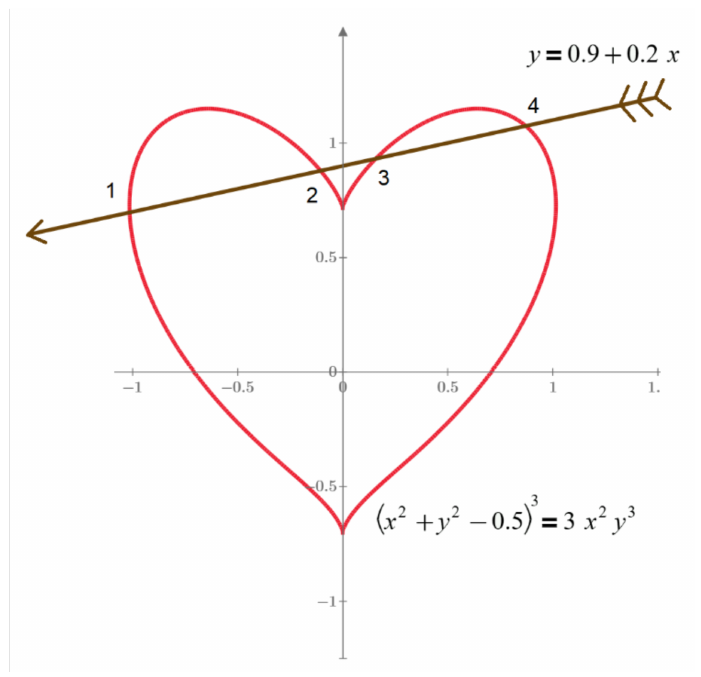
Figure 9. Graph of system (2), built in